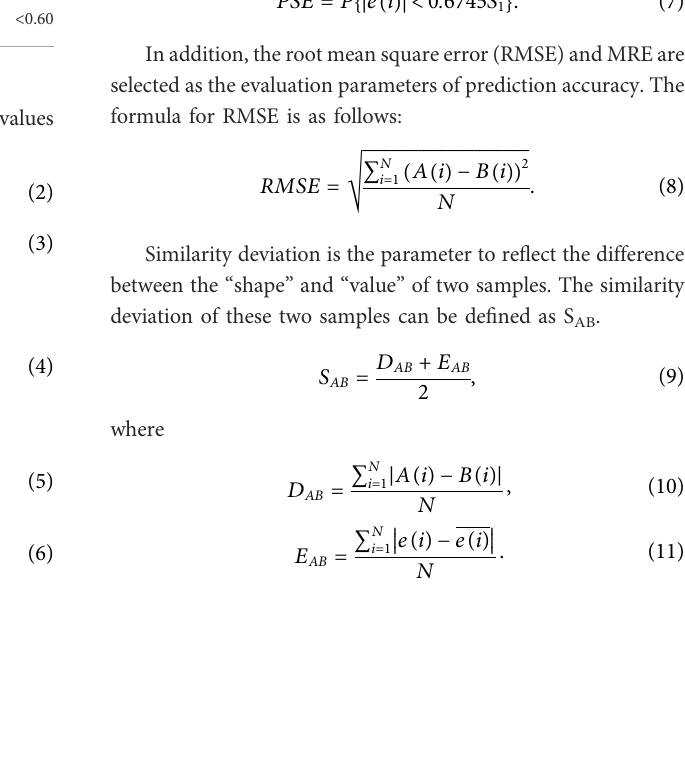
the residual between the fi rst and second samples. The calculation formula of the probability of small error (PSE) is de fi ned in Eq. 7. Table 1 shows the relationship between the aforementioned parameters and the grey model accuracy.